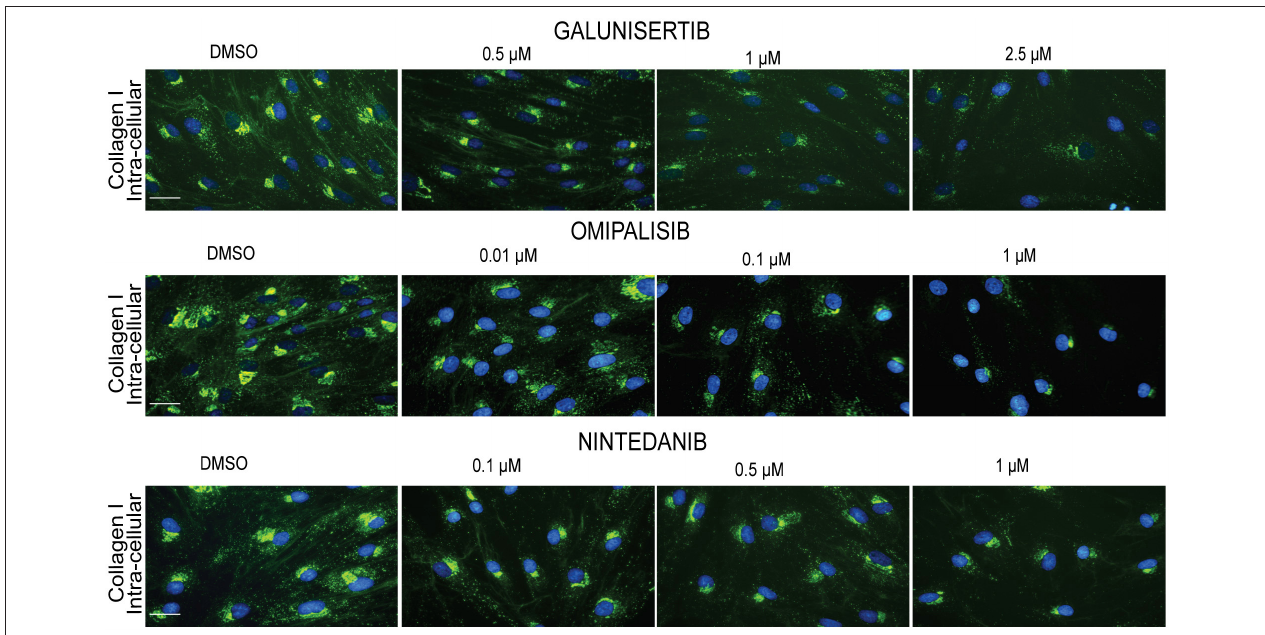
FIGURE 9 | Effect of anti-fibrotic compounds on collagen I synthesis in dermal myofibroblasts. Immunofluorescence staining of intra-extracellular collagen I in human dermal fibroblasts after 48h in the presence of TGF β 1 cultured with macromolecular crowder PVP40 and treated with anti-fibrotic compounds Galunisertib, Omipalisib and Nintedanib. Showing 1 FVO; DAPI, collagen 1, magnification 40x, scale bars 200 µ